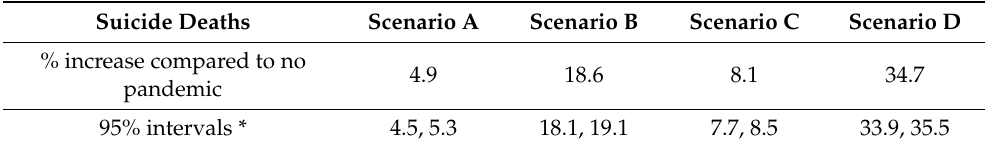
Table 1. Percent increase in cumulative suicide deaths over the period 2020–2041 (with 95% intervals) for the four COVID-19 mental health scenarios.